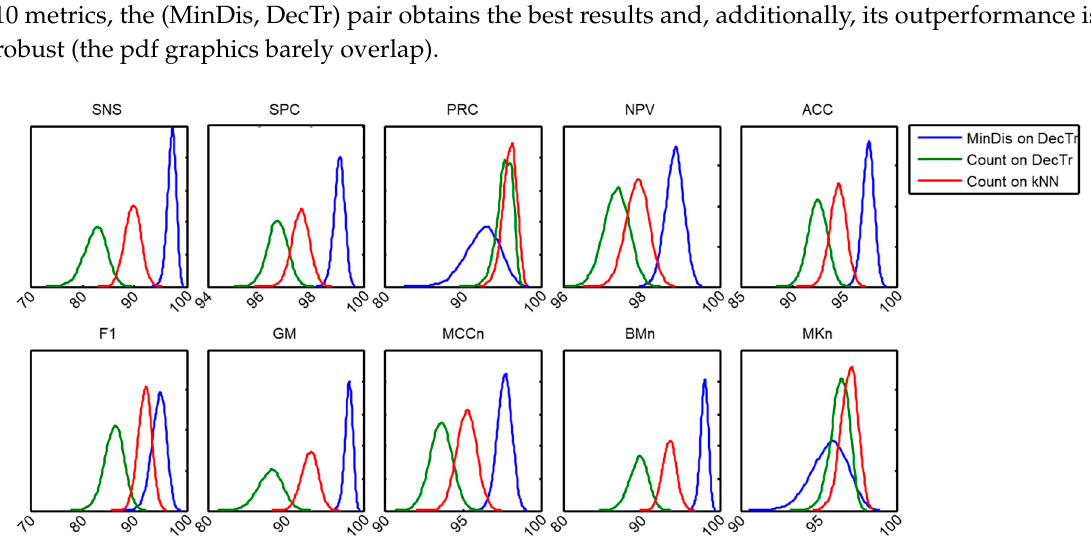
Figure 21. Probability density function of each performance metric for 3 selected pairs of (score, frame) classifiers. Table 9. Performance improvement (%) over the simpler counting methods.